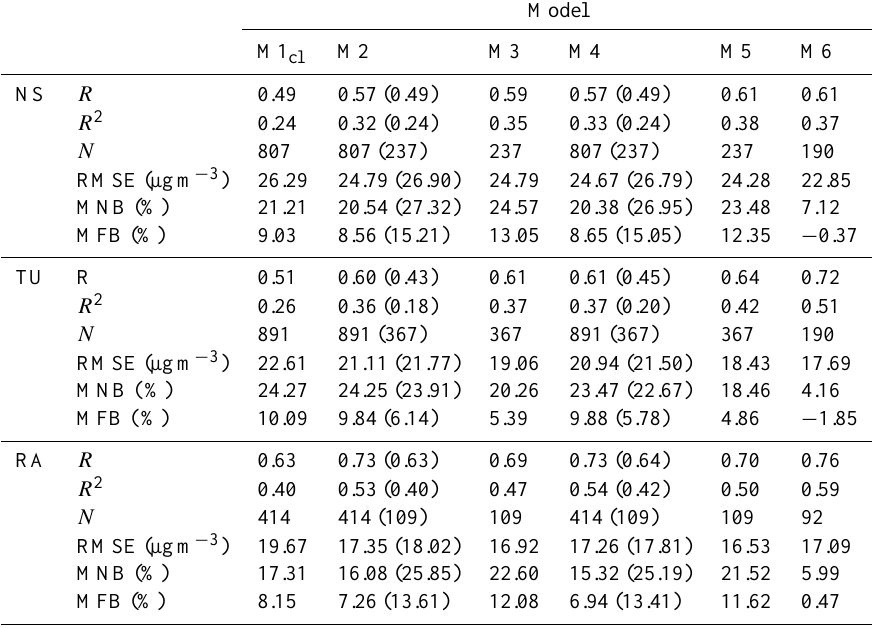
Table 6. Spatial variations of the correlation coefficient ( R ), root mean square error (RMSE), mean normalized bias (MNB), and mean fractionalized bias (MFB) between measured PM 10 concentrations and those estimated from the different empirical linear models for the three different site categories, using the data collected by AERONET and MODIS, during the DRAGON-Asia campaign period in